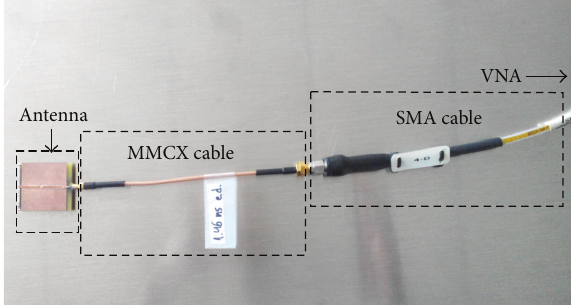
Figure 11: Impedance measurement